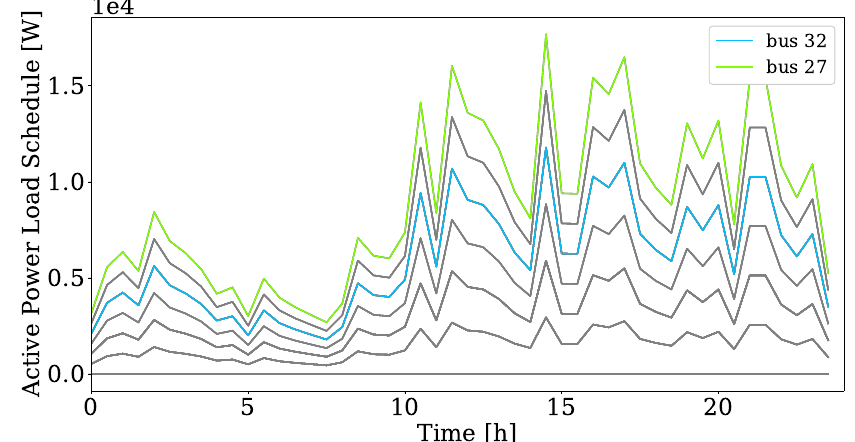
Figure 4. Forecasts of the load profiles.